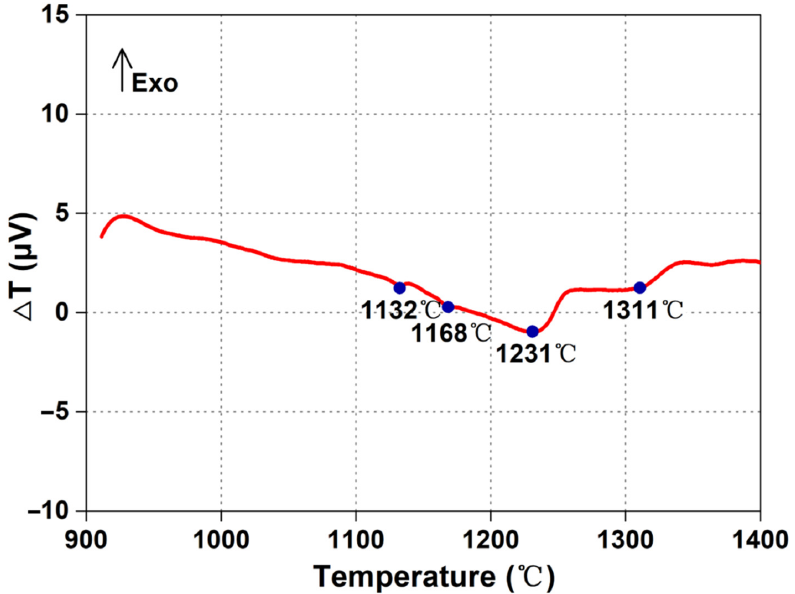
Figure 2. The DTA results of Ti42Al5Mn alloy showing the phase transformation Table 1. Summary of heat treatments performed on the as-forged TiAlMn and TNM alloys.